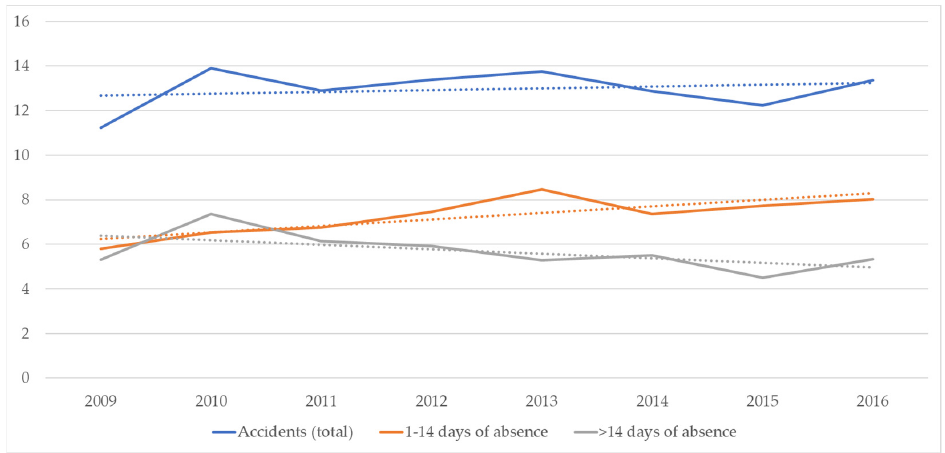
Figure 14. Incidence rates in erection of other roof covering and frames. Based on data from [17–24,27].